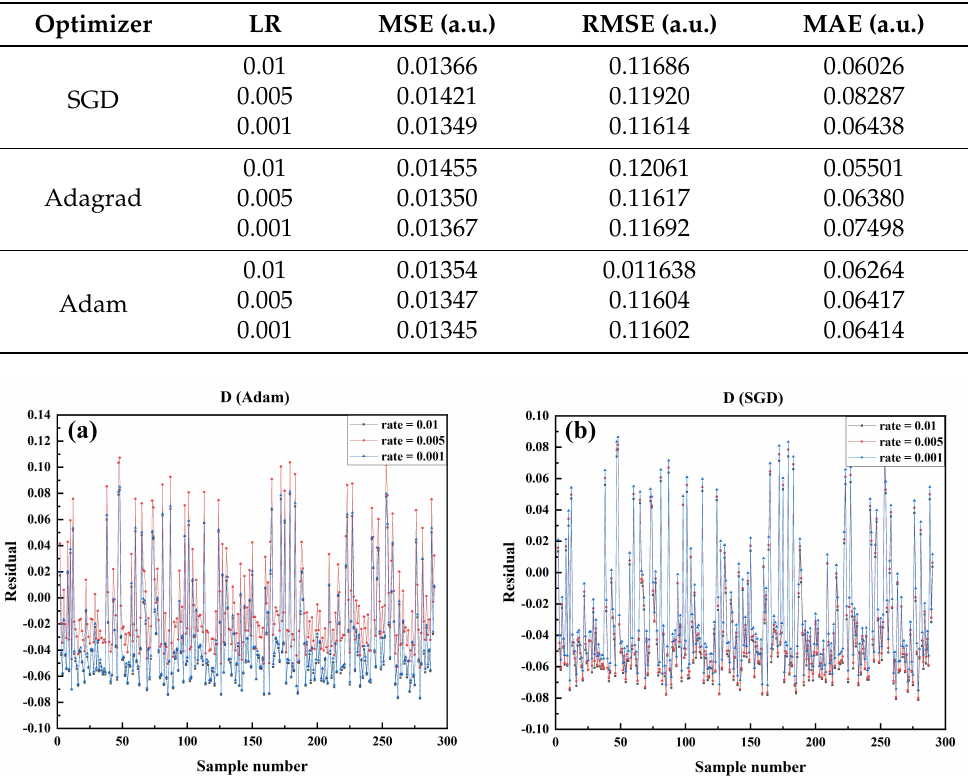
Table 6. Performance evaluation results for predictions of D on the test dataset with models trained with different optimizers and different LRs.